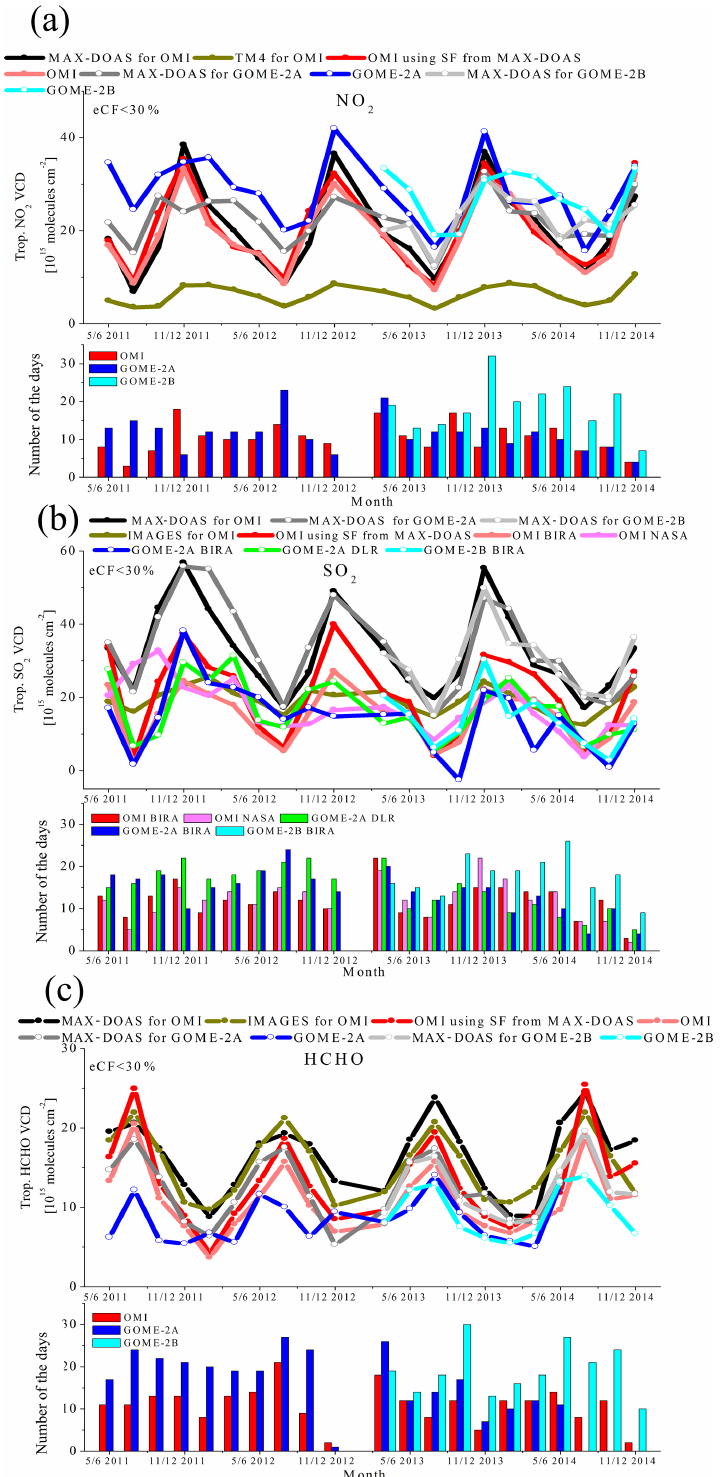
Figure 12. Bi-monthly-averaged tropospheric VCDs of NO 2 (a) , SO 2 (b) and HCHO (c) derived from coincident satellite and MAX-DOAS observations for eCF<30%. Also shown are the corresponding CTM results (TM4 for NO 2 , IMAGES for SO 2 and HCHO). In all subfigures the red and light red lines indicate the improved OMI tropospheric VCDs using the SFs from MAX-DOAS and the VCDs from the original OMI products, respectively. The numbers of the available days are shown in the bottom panel of each